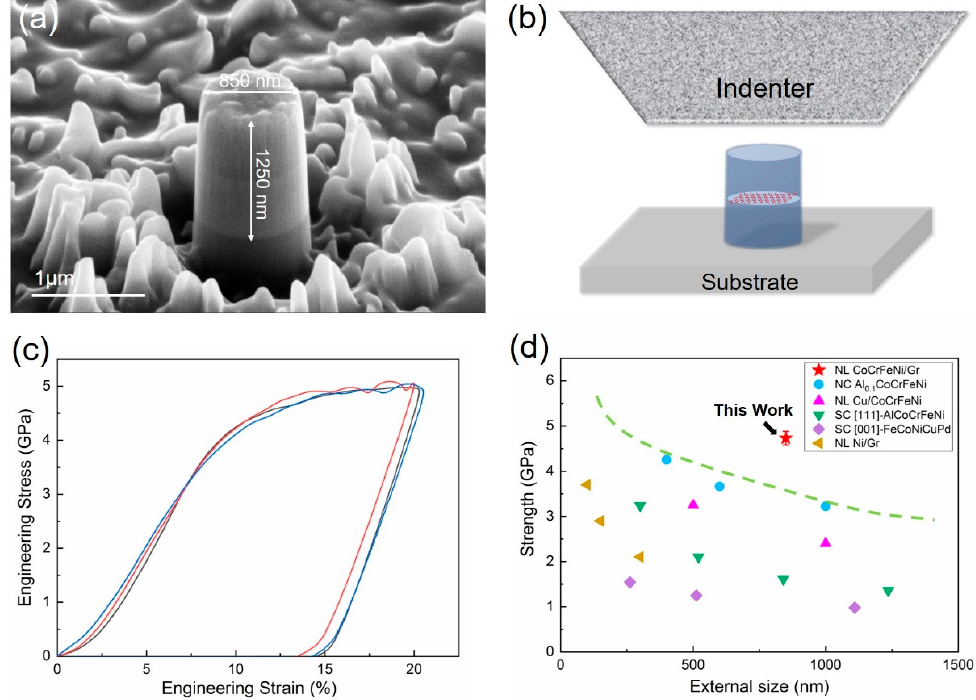
Figure 4. Illustration of ( a ) as-fabricated NL HEA/graphene micropillar; ( b ) the uniaxial micro- compression mechanical testing; ( c ) uniaxial compressive stress–strain curves of NL HEA/graphene micropillars; ( d ) the strength vs. the external size of the NL HEA/graphene micropillar compared with other related materials, including nanocrystalline (NC) Al 0.1 CoCrFeNi HEA film pillar, NL CoCrFeNi/Cu micropillar, single crystalline (SC) [111]-orientated AlCoCrFeNi HEA pillar, SC [001]- orientated FeCoNiCuPd HEA pillar, and NL Ni/graphene pillar.